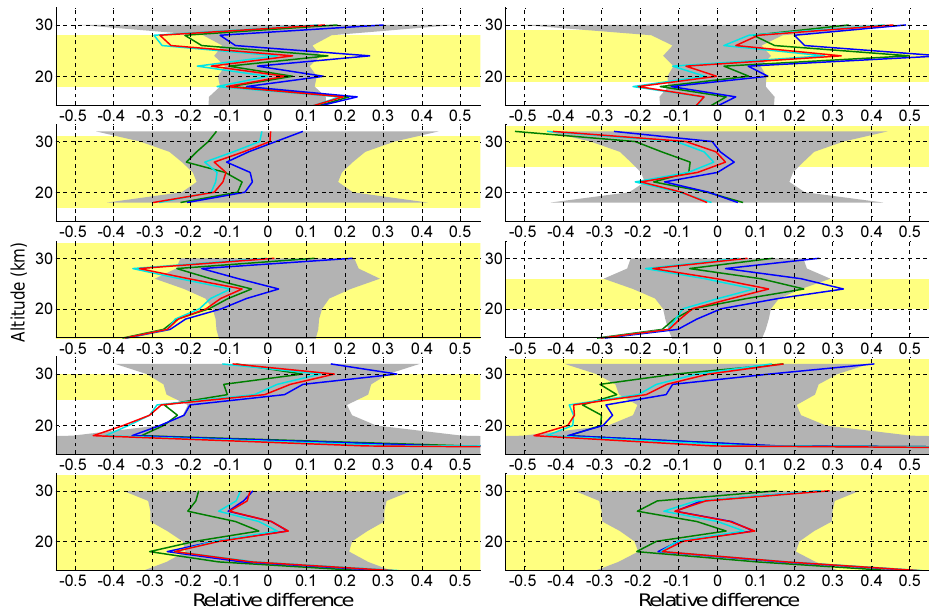
Figure 21. Same as Fig. 20 but showing the relative differences for the SCIAMACHY results with respect to the balloon